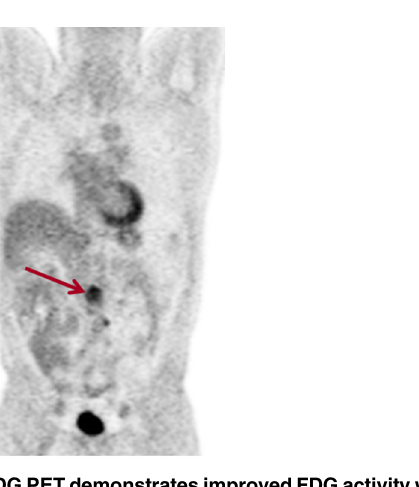
Table 4 shows the results based on EORTC criteria for predicting PFS at 12 months. After cycle 2 of sunitinib, 1/12 patients had complete response (CR), 4/12 patients had par- tial response (PR), 1/12 patients had progressive disease (PD), and 6/12 patients had stable dis- ease (SD) based on EORTC criteria. Of the patients that had a PR, the mean change of SUVmax in targeted lesions was 6.0 ± 3.3. EORTC criteria present relatively high AUC and accuracy, but lower than other indexes on baseline PET.